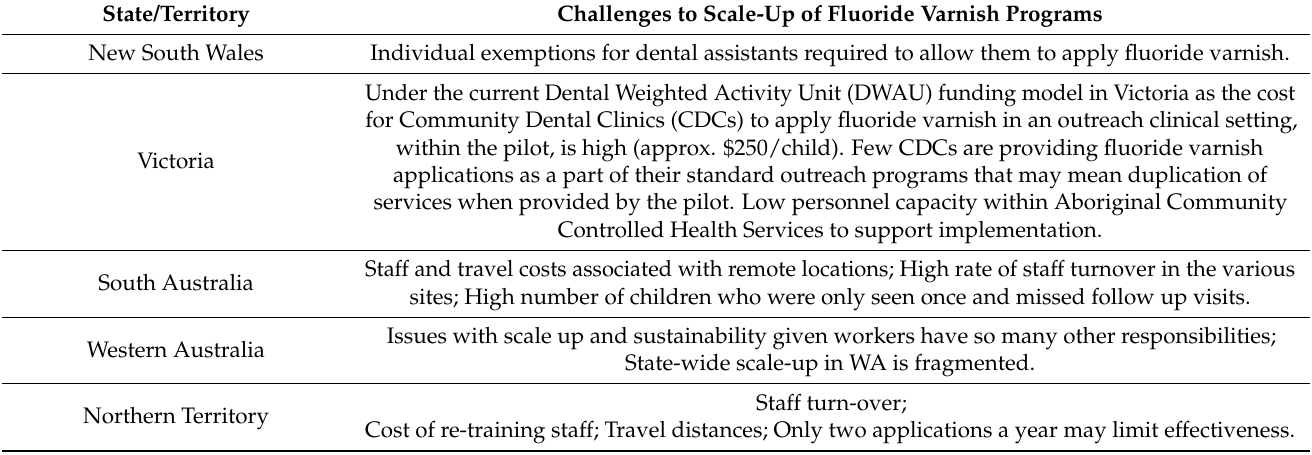
Table 2. Challenges to scale-up of fluoride varnish programs by State and Territory.